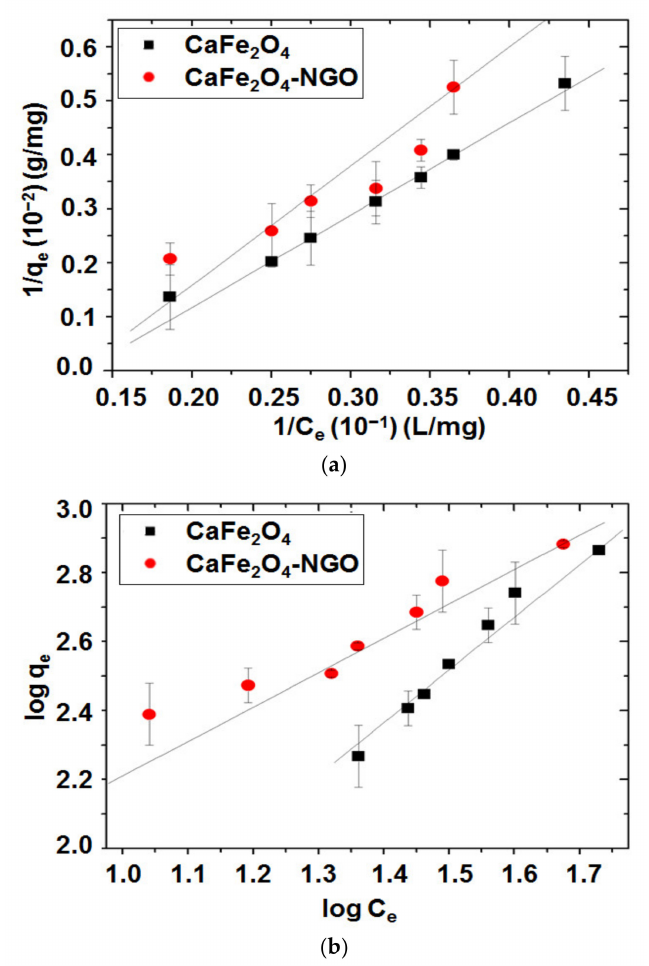
Figure 8. ( a ) Langmuir and ( b ) Freundlich isotherm plots for adsorption of Pb(II) ions. (Experimental